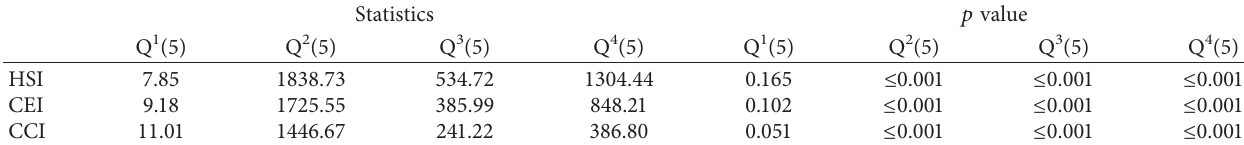
Table 2: Autocorrelation tests of the first four moments of